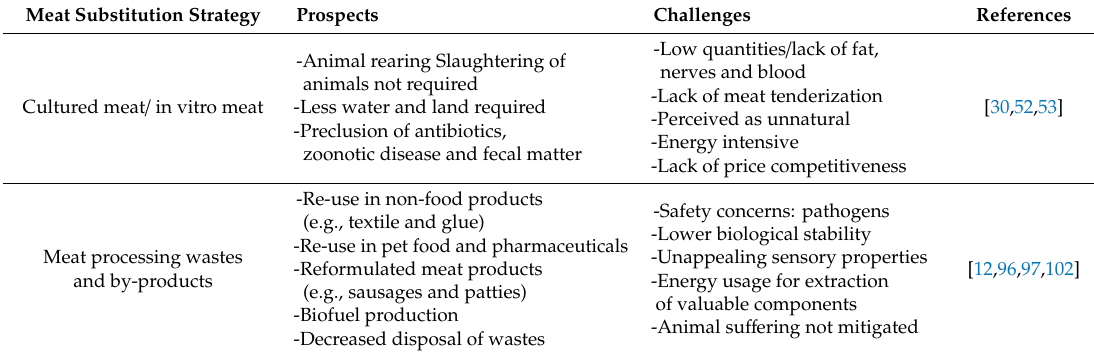
Table 5. Merits and demerits of cultured meat, and meat wastes and by-products. Meat Substitution